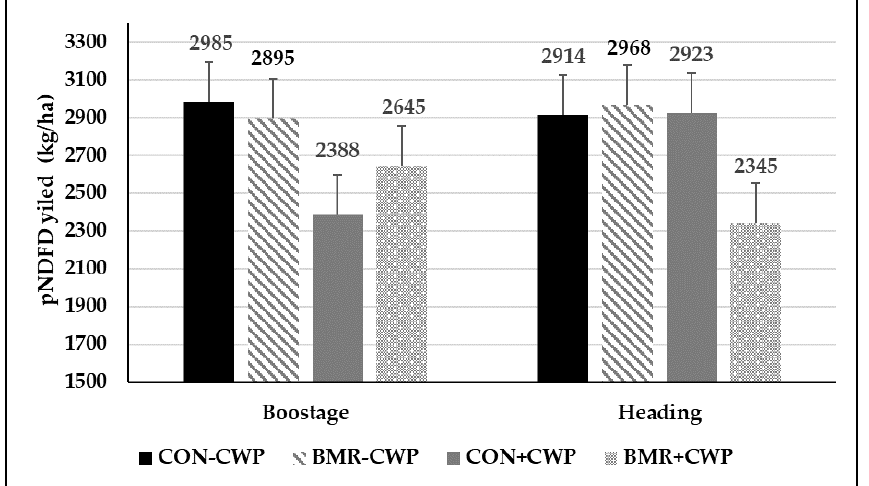
Figure 5. Potentially digestible NDF (pdNDF) yield per ha for Trial 2; vertical bars indicate standard errors of the mean.